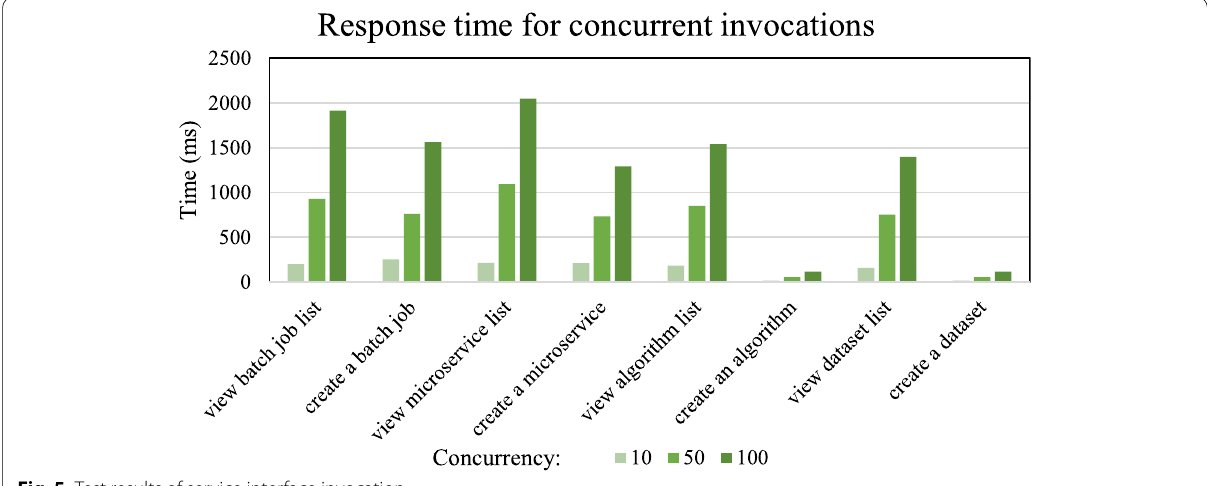
Fig. 5 Test results of service interface